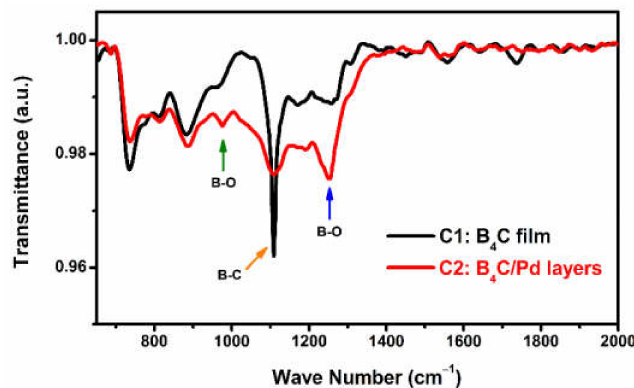
Figure 7. The Fourier-transform infrared spectroscopy (FTIR) absorption spectra of the B 4 C film and B 4 C/Pd layers placed in the dry oxygen-rich